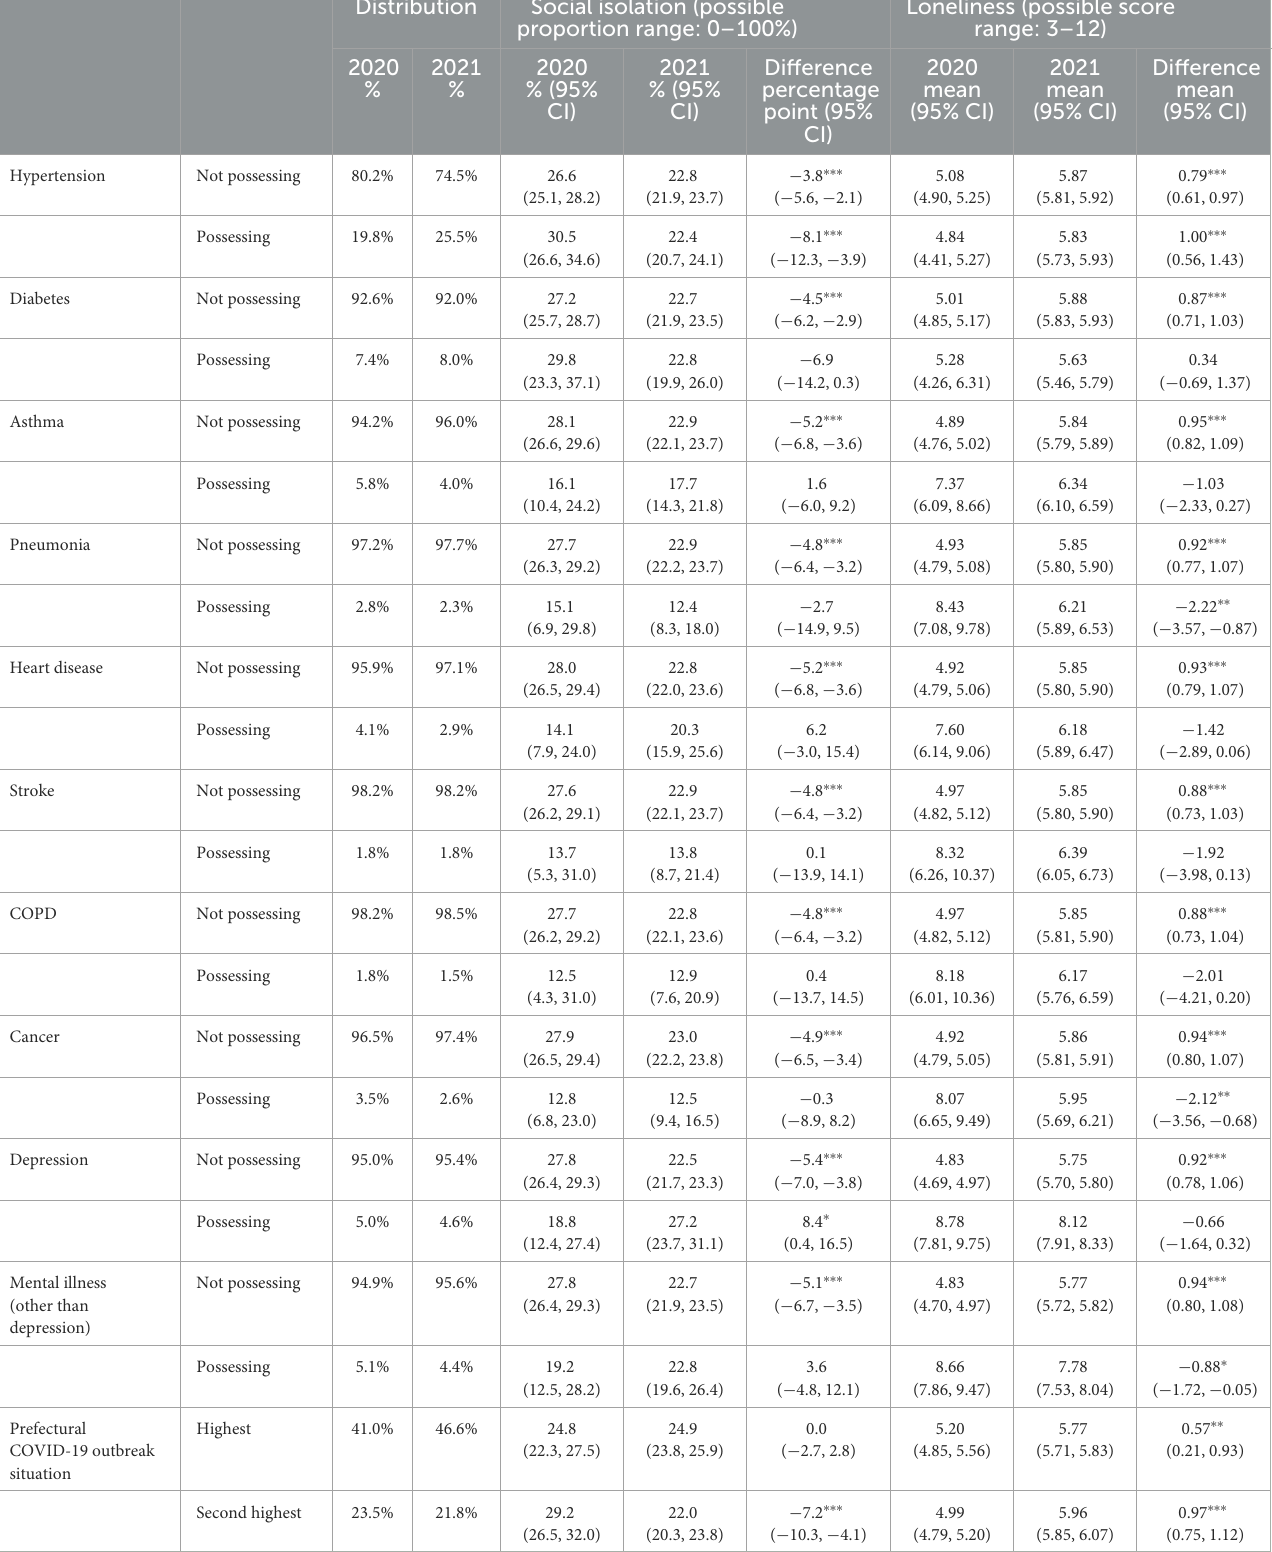
TABLE 3 The weighted prevalence of social isolation and loneliness by health conditions and prefectural in the COVID-19 outbreak situation. Distribution Social isolation (possible proportion range: